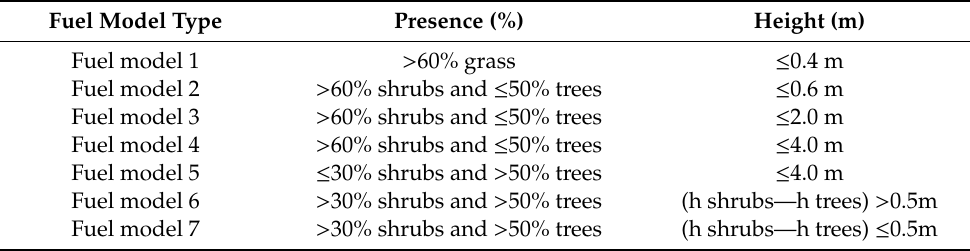
Table 1. Description of the seven models of Prometheus classification for